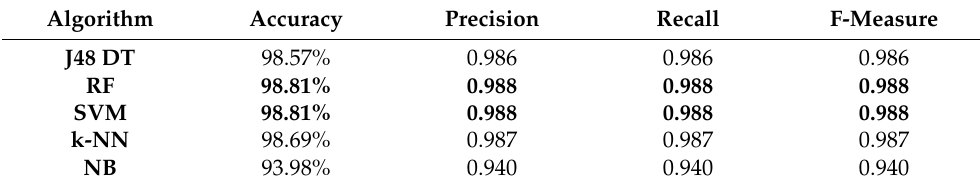
Table 9. Major accuracy measures from the 10-fold cross-validation performance of the models built using the supervised machine learning algorithms.